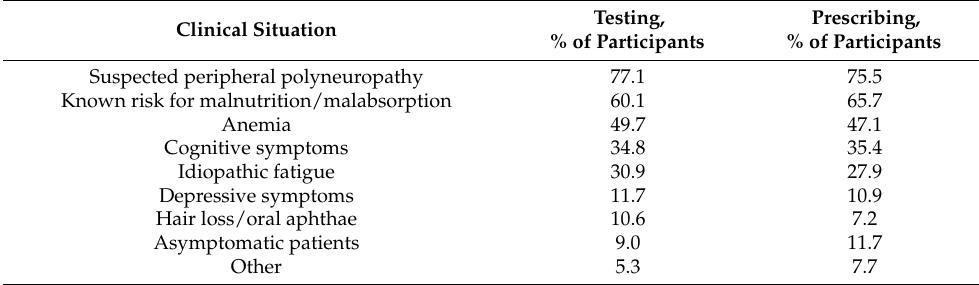
Table 2. Clinical situations appearing in the top 3 most common reasons for testing or prescribing vitamin B12 during the past year, according to GPs. For each condition, the percentage of participants indicating it as an answer to the corresponding question is reported. “Asymptomatic patients” refers to vitamin B12 testing as a screening procedure and to prescriptions after screening results suggestive for vitamin B12 deficiency.